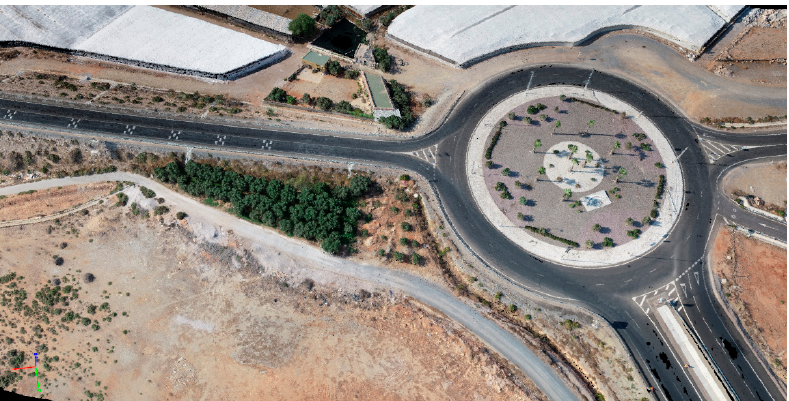
Figure 3. 3D cloud point corresponding to the northern end of the study site, showing a roundabout and several greenhouses.